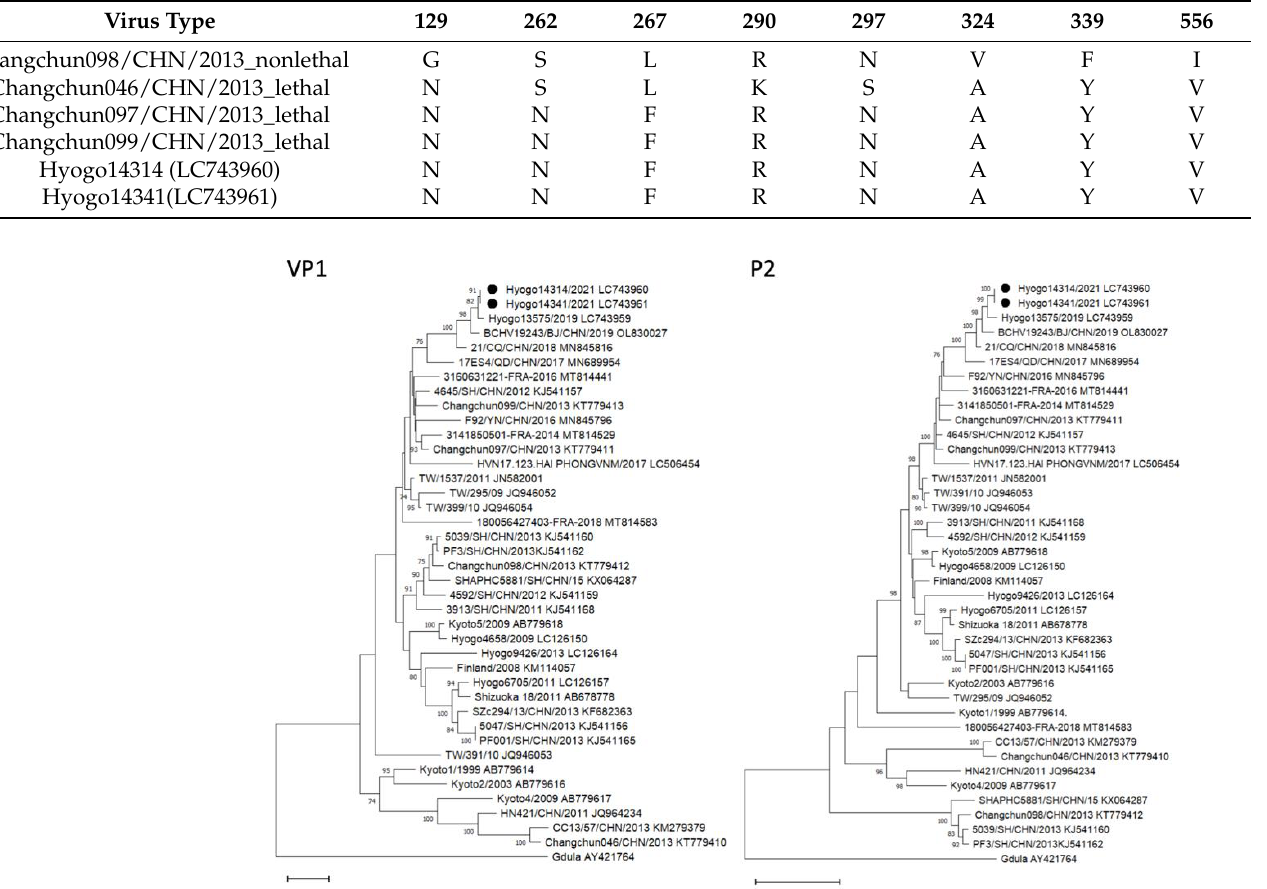
Table 3. Alignment of amino acid sequences of the P2 region of CV-A6 Hyogo strains with the lethal and nonlethal strains.